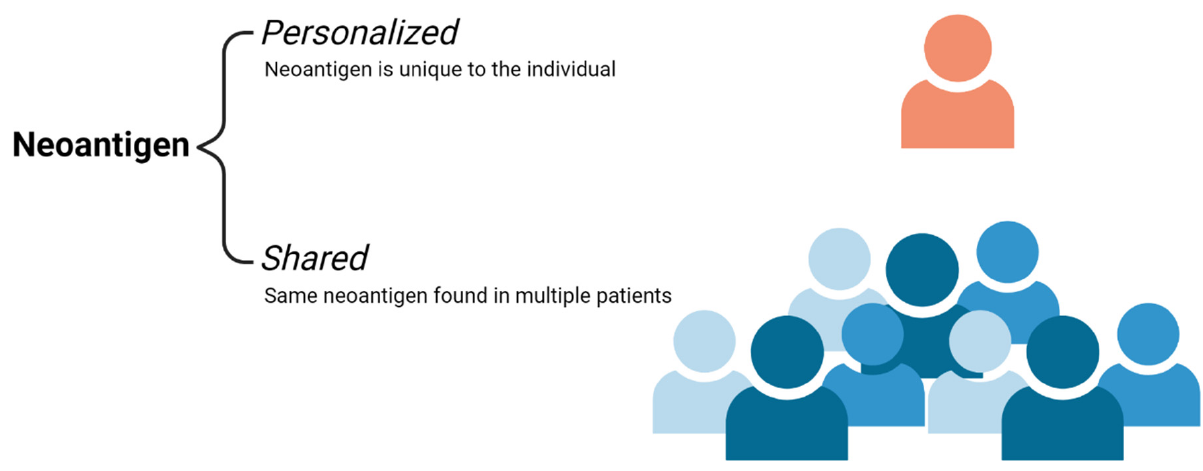
Figure 2. Neoantigen Subtypes. Personalized neoantigens are antigens secreted from the tumor that is unique to the individual. Shared neoantigens are tumor unique antigens that are found across multiple individuals or a subset of a patient population. Credits: Images were created using